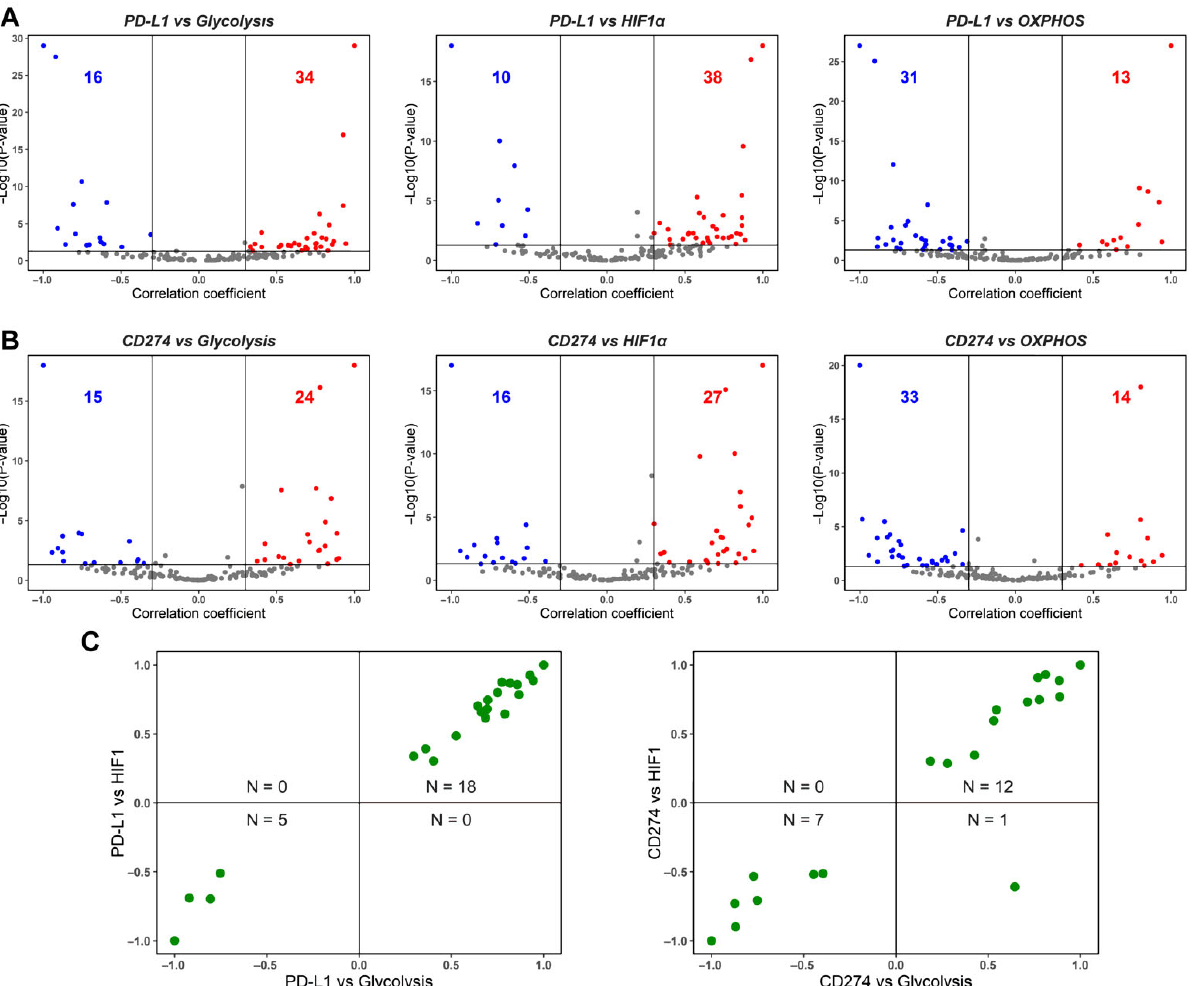
Figure 2. Association between PD-L1, glycolysis, and OXPHOS. ( A ) Volcano plots showing the correlation coefficient, ‘R’ (x-axis), and -log 10 ( p -value) (y-axis) for PD-L1 vs. glycolysis scores ( left ) and PD-L1 vs. HIF-1 α ( middle ) and PD-L1 vs. OXPHOS ( right ). Boundaries for significant correlation are set at R > ± 0.3 and p < 0.05. Same as ( A ) but for ( B ), CD274 gene expression vs. glycolysis ( left ) , CD274 gene expression vs. HIF-1 α ( middle ), and CD274 gene expression vs. OXPHOS ( right ). ( C ) Two-dimensional scatter plot depicting correlation coefficient ‘R’ between PD-L1 vs. glycolysis (x-axis) and PD-L1 vs. HIF-1 α scores (y-axis) ( left ) and CD274 expression vs. glycolysis (x-axis) and CD274 vs. HIF-1 α scores (y-axis) ( right ). ‘N’ denotes the number of significant data points lying in each quadrant.